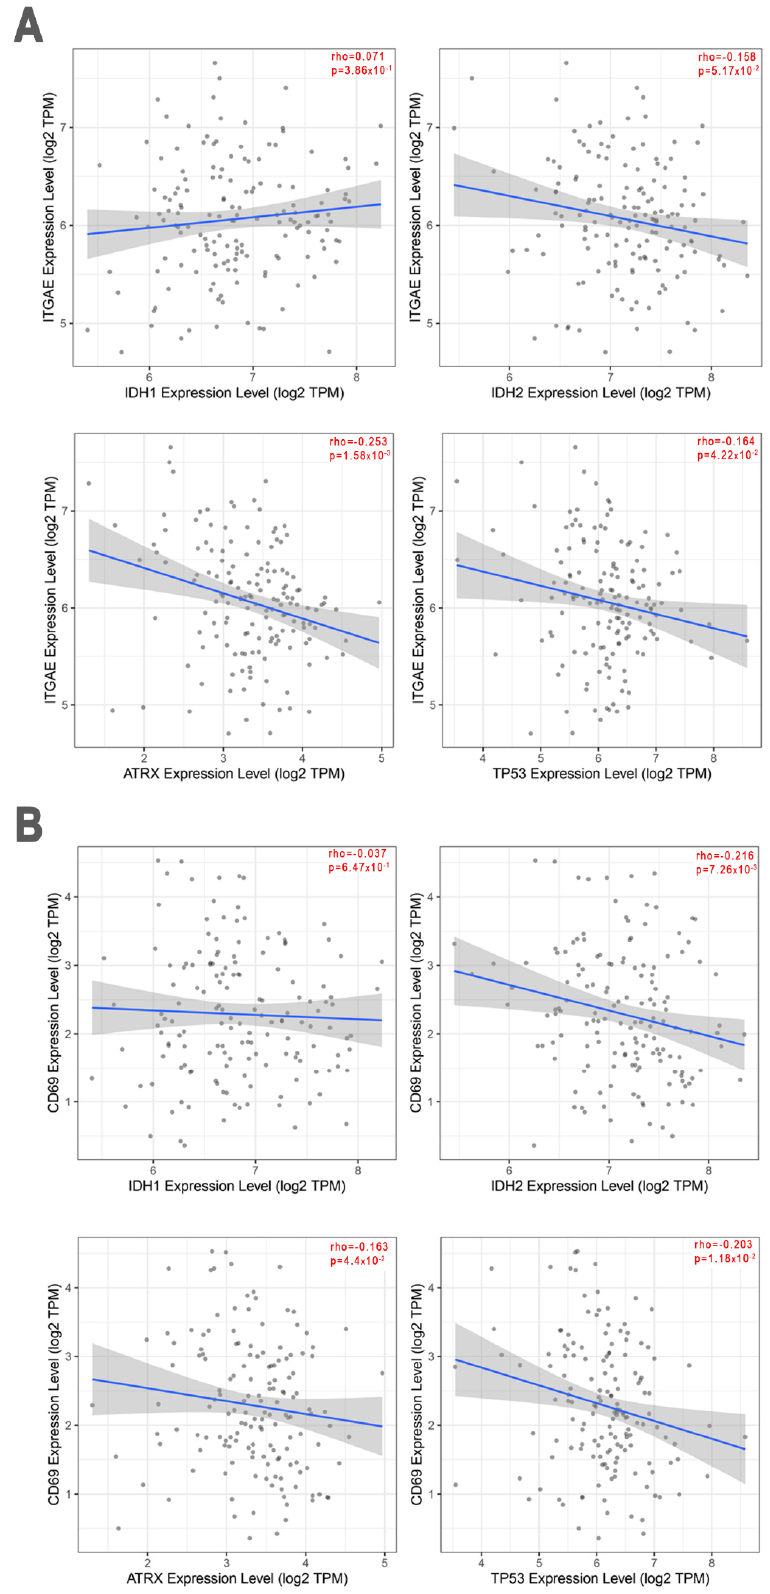
Figure 6. Spearman correlation test from EPIC on a cohort of n = 153 patients with GBM. Scatter plots show the correlations between ITGAE ( A ) or CD69 ( B ) gene expression and the molecular markers of